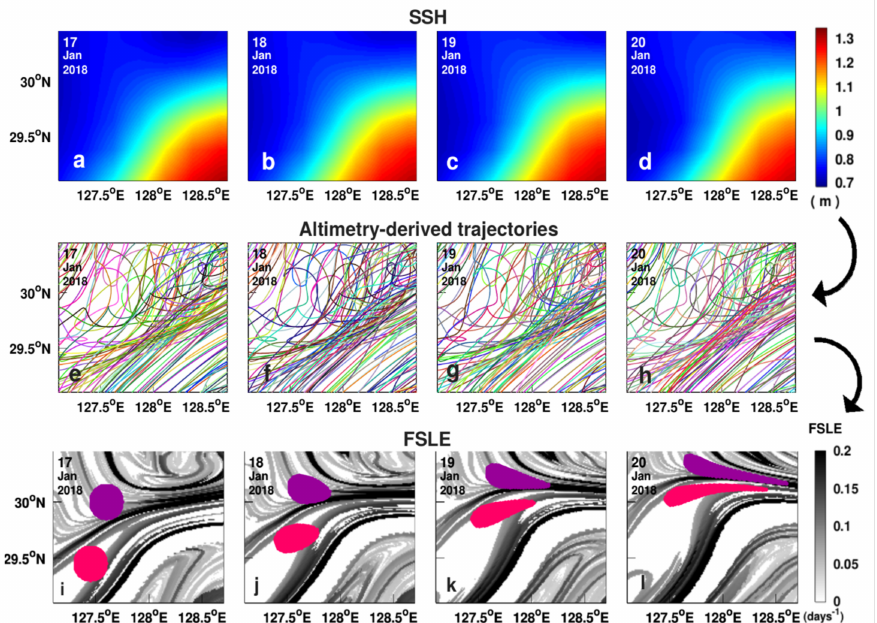
Figure 1. Sketch of a Lagrangian analysis applied to a velocity field (in this case, altimetry-derived geostrophic velocities). Panels ( a – d ) correspond to altimetry maps highlighting the daily sea surface heights from the 17th to 20th of January 2018 in a frontal area near the region of the East China Sea accident. The first step leading to the calculation of a Lyapunov field is the computation of backward Lagrangian trajectories depicted in panels ( e – h ). Panels ( i – l ) show the finite-size Lyapunov exponent in the same area, identifying oceanic Lagrangian fronts. The daily shape deformation of two passive tracers (in purple and fuchsia) due to a nearby Lyapunov front (black filament) is added as an